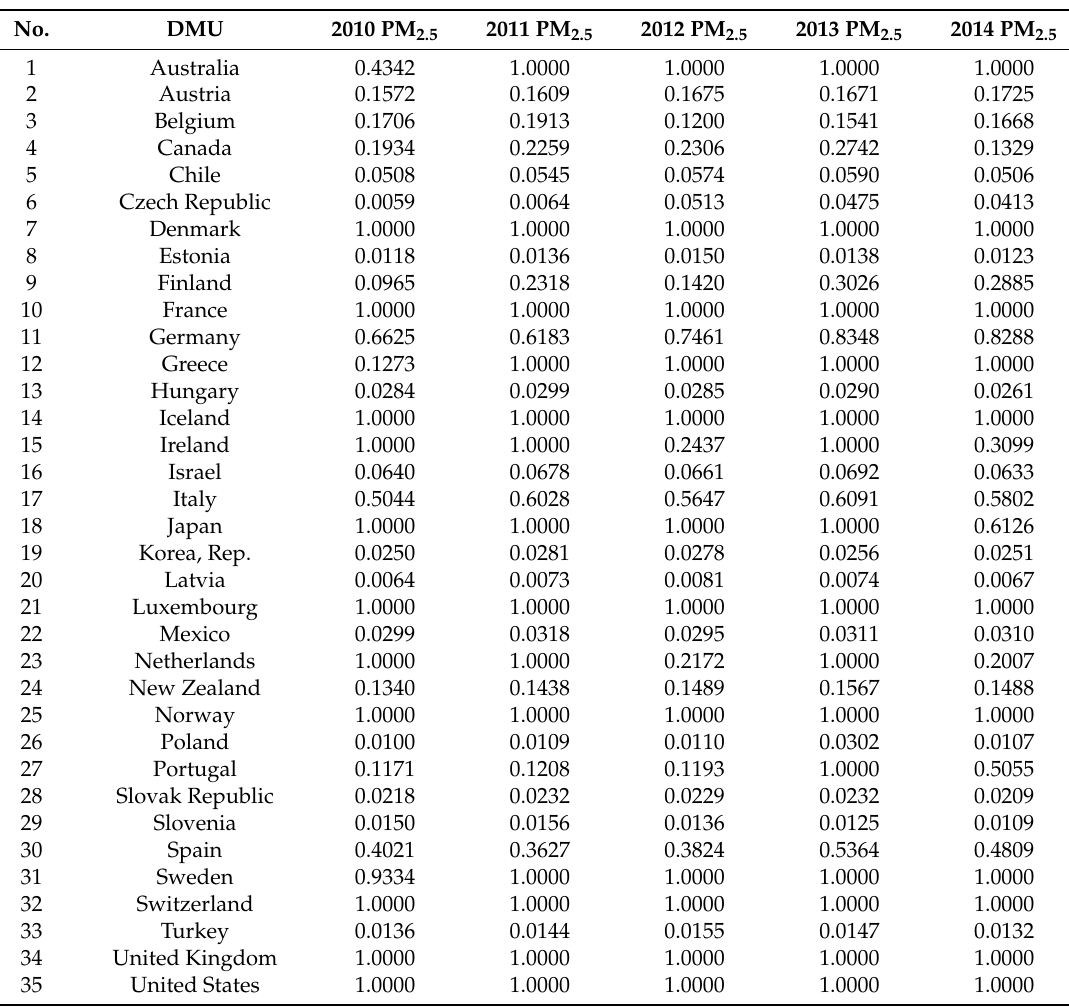
Table 8. PM 2.5 emissions efficiency from